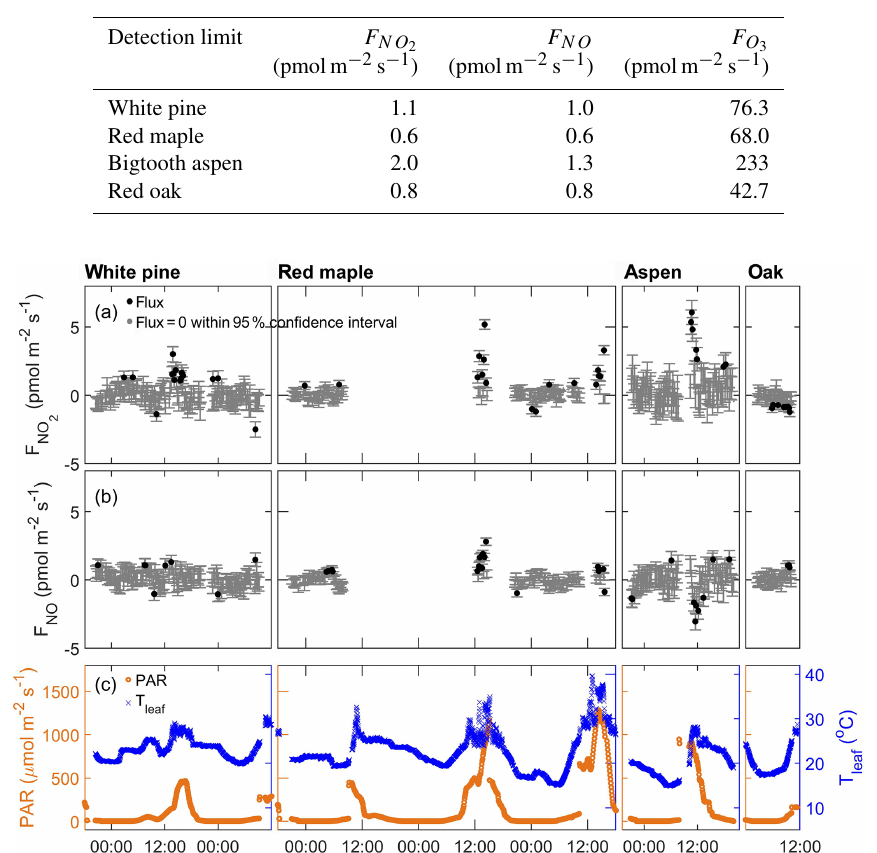
Figure 3. Apparent fluxes of NO 2 and NO when the enclosures were purged with scrubbed air. From left to right, each panel corresponds to the enclosure of white pine, red maple, bigtooth aspen, and red oak. From top to bottom: (a) NO 2 flux, (b) NO flux, and (c) PAR (left axis, orange) and temperature of the enclosure leaves (right axis, blue). In panels (a) and (b) , fluxes that are indistinguishable from zero within the 95% confidence interval are represented by gray dots; statistically significant fluxes are represented by black dots; error bars represent 1 σ measurement uncertainties propagated through the